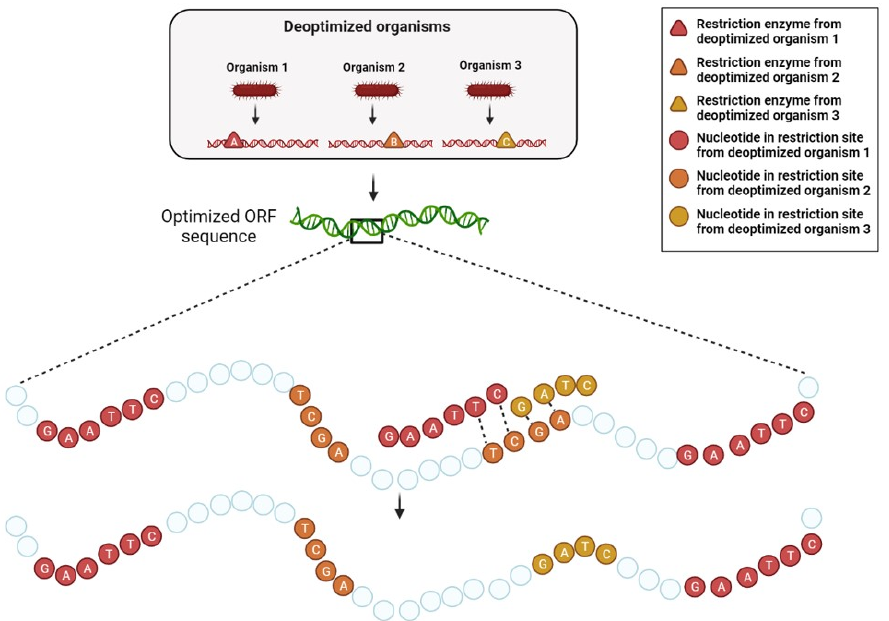
Figure 7. Restriction sites algorithm. The restriction enzymes (triangles) are extracted from the wanted and unwanted hosts respectively; the recognition sites of the enzymes are illustrated by squares.